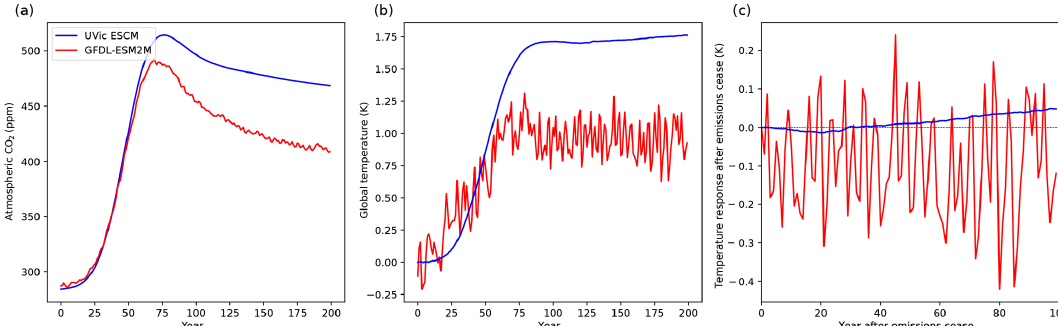
Figure 3. Example results from simulation B1 from the UVic ESCM (Weaver et al., 2001; MacDougall and Knutti, 2016; blue) and GFDL- ESM2M (Dunne et al., 2012, 2013; red) models. (a) CO 2 concentration simulated by the two models; (b) simulated global mean surface air temperature for the same period; (c) global mean temperature response from year 100 onwards with zero subsequent